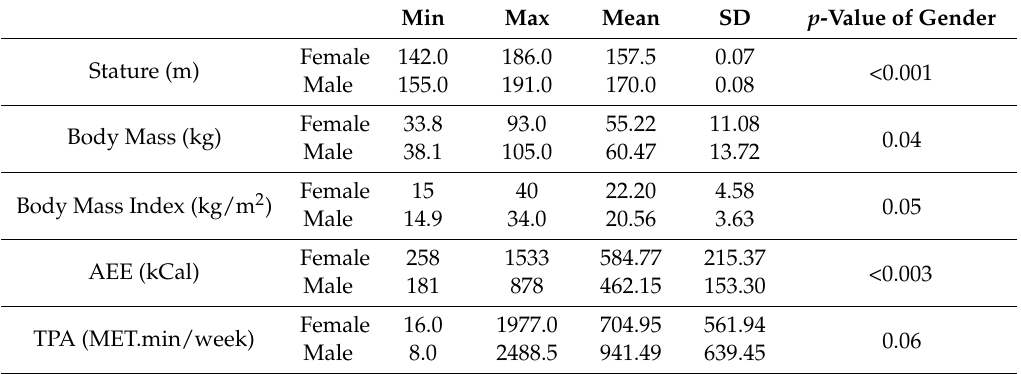
Table 1. Descriptive information (min, max, mean, standard deviation (SD) and p -values) of the participants. Min Max Stature